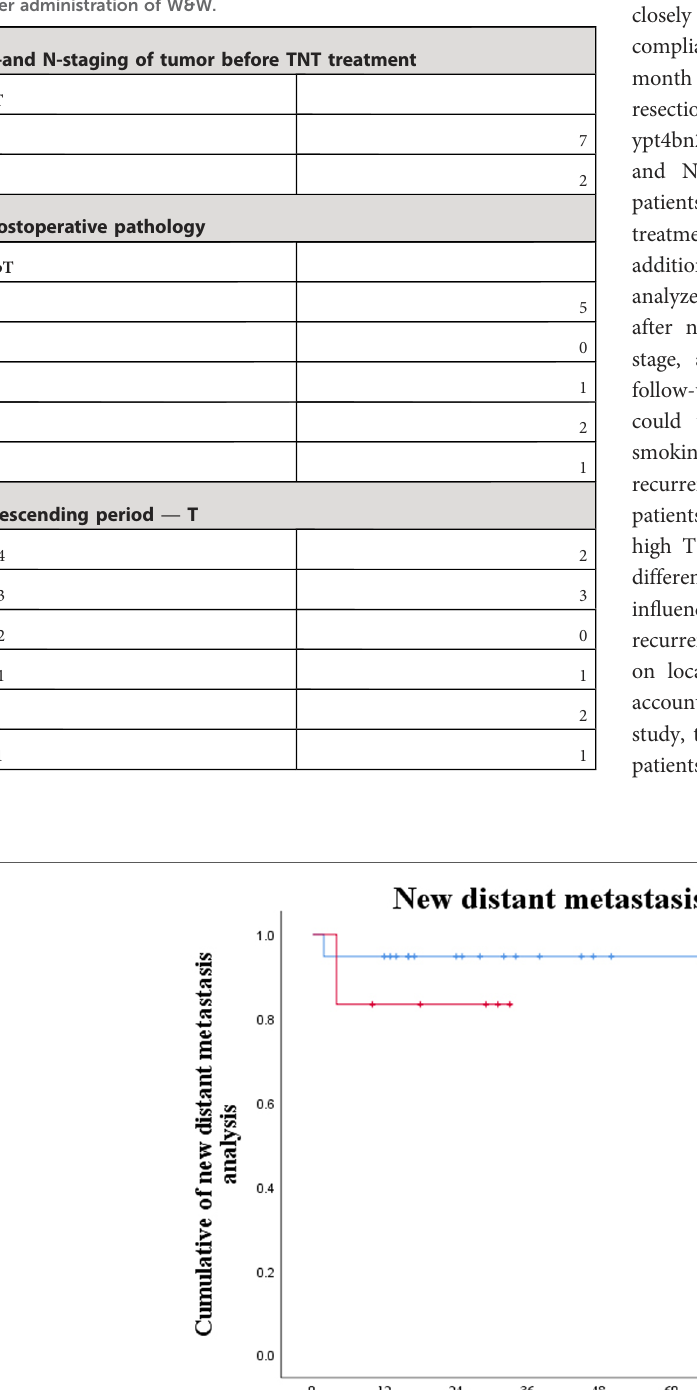
TABLE 6 Comparison of descending phases of T-stage patients who were suspected to have local recurrence and accepted for remedial surgery after administration of W&W.